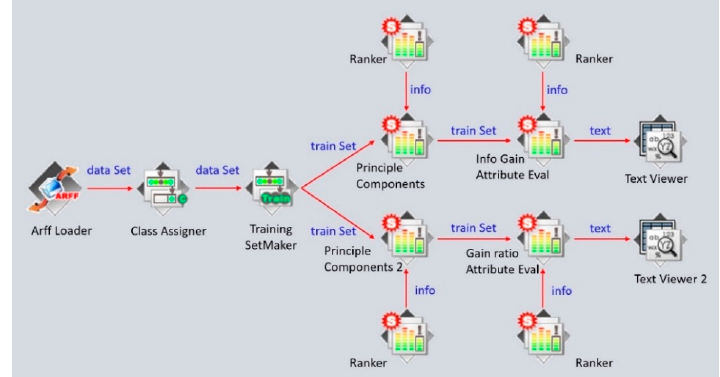
Figure 2. WEKA Feature selection process.